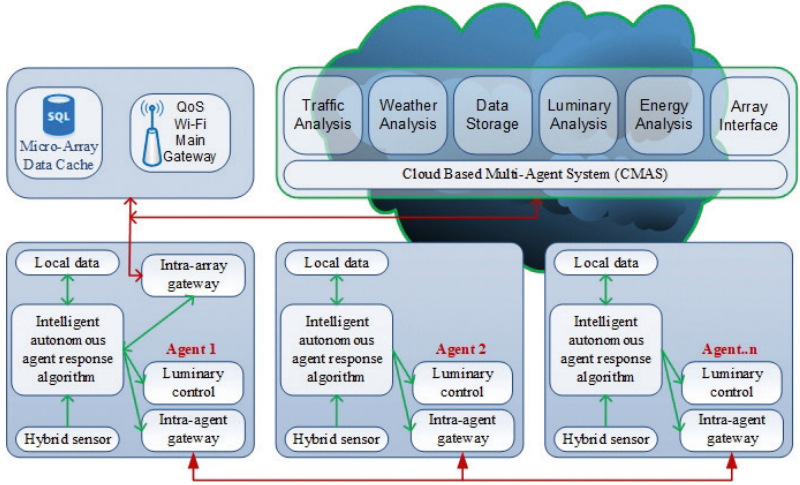
Figure 7. Cloud-based multi-agent system